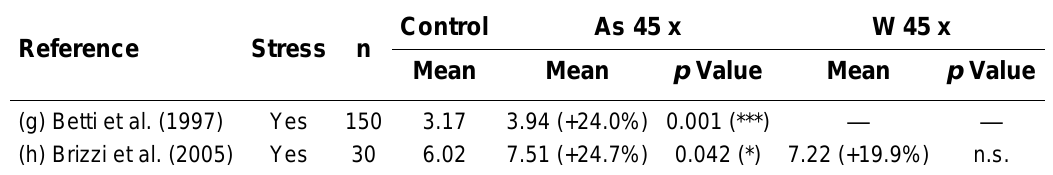
Wheat Growth Model: Mean Stem Length (cm) and Mann-Whitney Test Significance